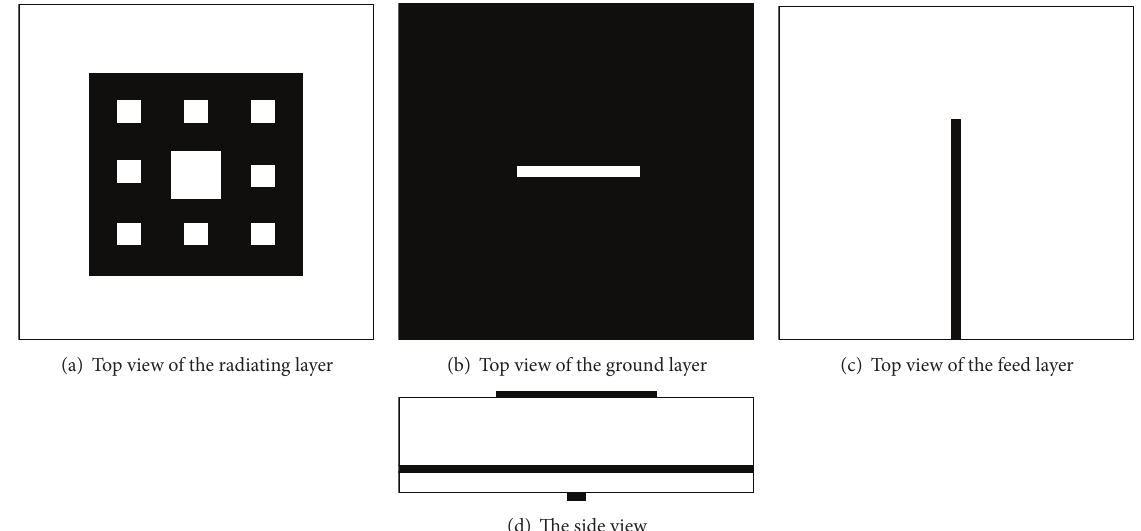
Figure 1: Geometry of the aperture coupled Sierpinski patch antenna. (a) Top view of the radiating layer. (b) Top view of the ground layer. (c) Top view of the feed layer. (d) The side view.